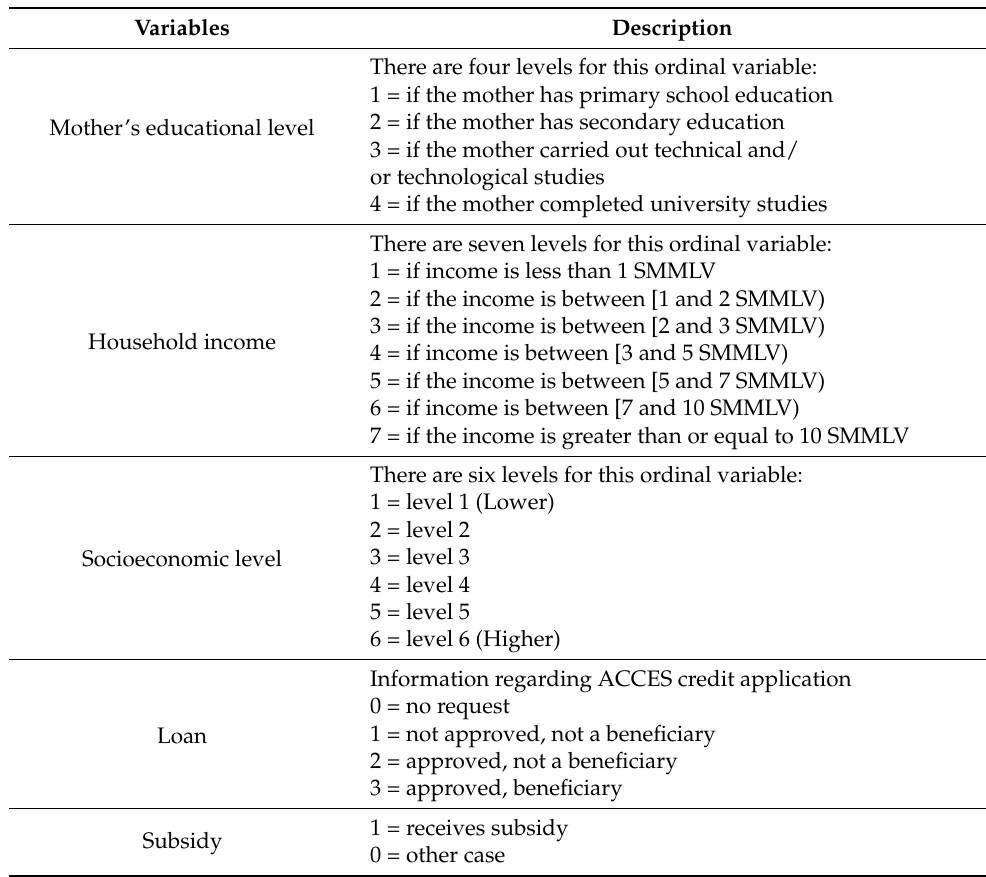
Table 1. Definition of variables used in